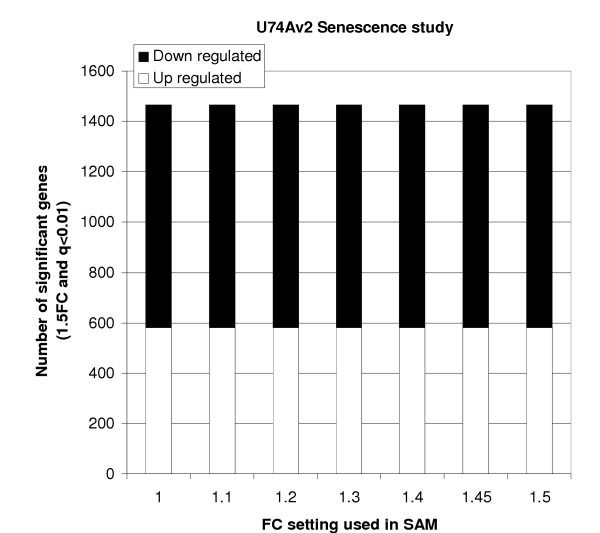
FC effects on the senescence data set: SAM analysis was used at various fold changes using the senescence data set while scoring genes with a q-value of <0.01 and FC>1.5. A comparison between non-senescent cells and senescent cells was used (two replicates of the senescent cells and four replicates of the non-senescent cells).